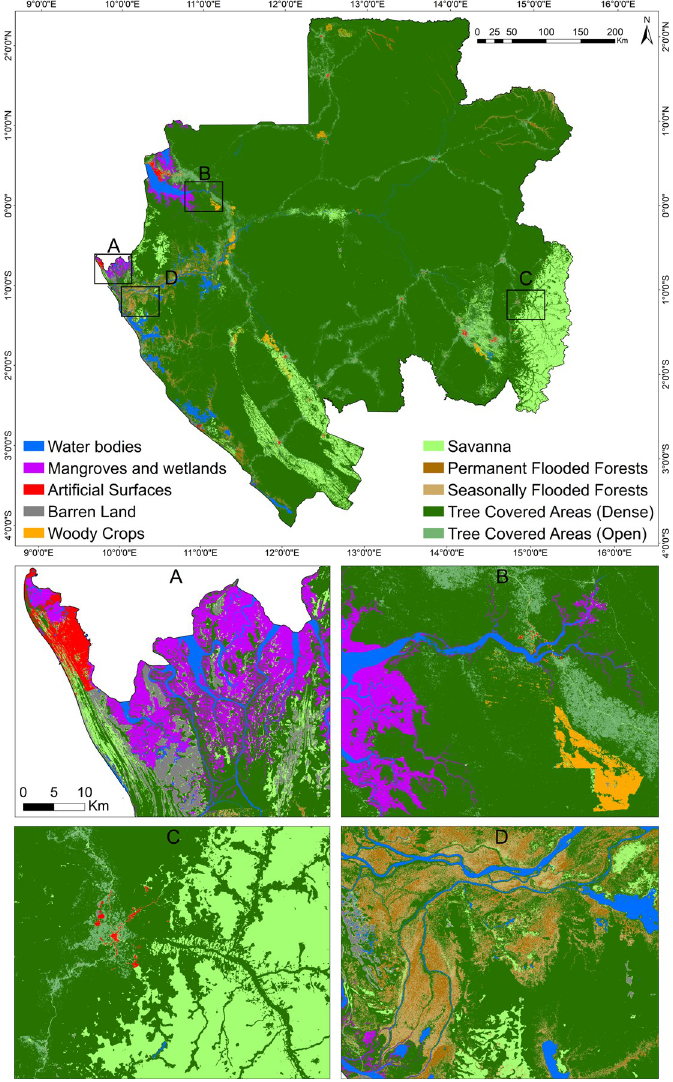
Fig 6. Random Forest model predicted land cover map for Gabon 2015. Regional subsets showing different land cover classes across Gabon in finer detail are shown (A-D).